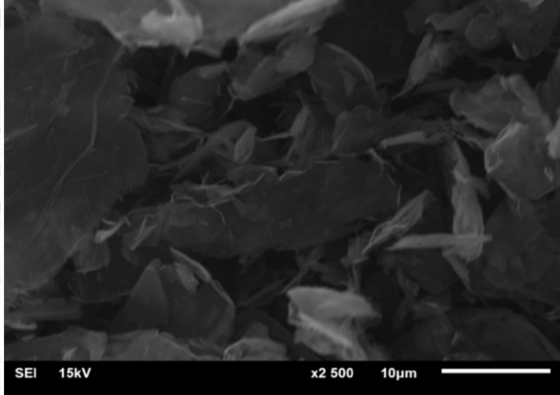
Figure 2. SEM characterization of graphene sheets.